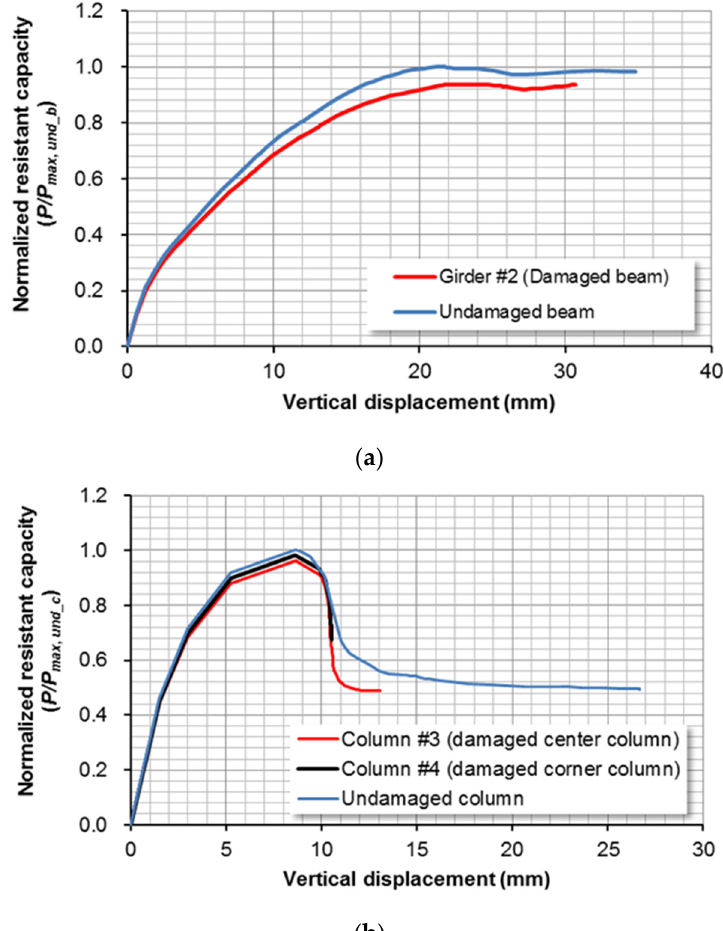
Figure 16. Comparison between load ‐ displacement relations of damaged and undamaged structural elements. ( a ) Girder #2. ( b ) Column #3 (exterior column) and #4 (corner column).